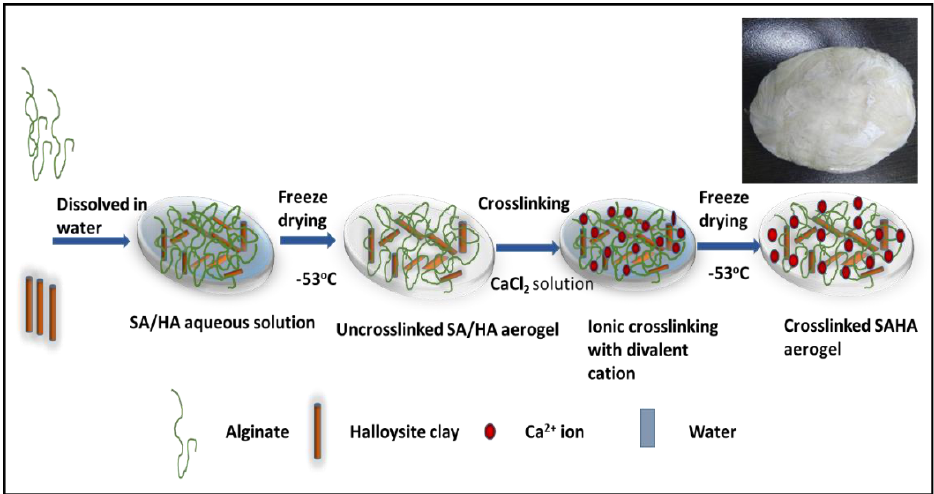
Figure 1. Schematic representation of the preparation of the sodium alginate–halloysite composite aerogel (inset: digital image of the as-prepared sodium alginate–halloysite (SAHA) aerogel).